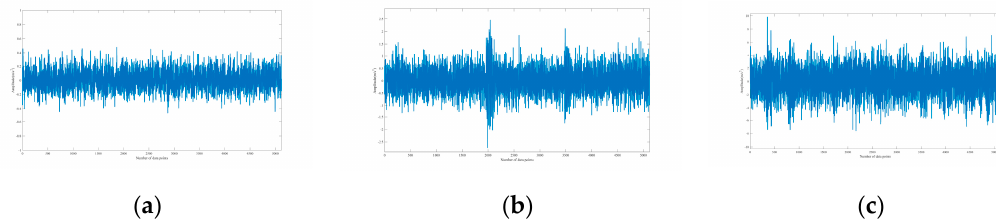
Figure 13. Simulation signals combined with noise (SNR = − 5 dB). ( a ) Normal; ( b ) roller fault; ( c ) outer ring fault at 6:00 position relative to the load center.